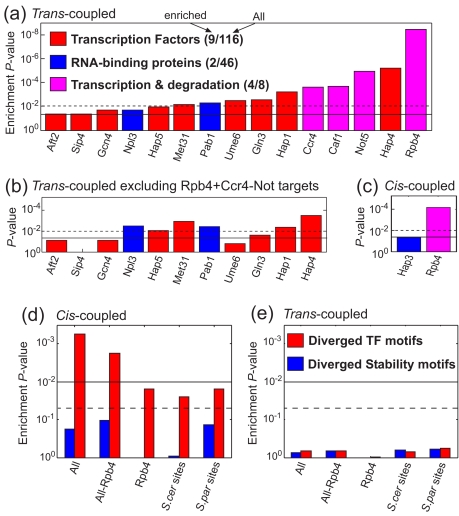
Coupling is associated with divergence of Rpb4/7, Ccr4-Not, and TF motifs.(a) Target-sets of various TFs [31], RNA-binding proteins [14], and two complexes implicated in both transcription and degradation (Rbp4/7 [32] and Ccr4-Not [33]) were examined for enrichment with trans-coupled genes. 15 and 10 datasets had significant enrichment below a p value of 0.05 (full line) and 0.01 (dashed line), respectively, and these are shown in order of statistical significance. The total numbers of analyzed datasets and those with significant enrichments are shown in parentheses. (b) Same as in (a) after excluding targets of Rpb4, Ccr4, and Not5. (c) Same as in (a) for enrichment with cis-coupled genes. (d) Diverged TF binding [31] (red) or mRNA stability [15] (blue) motifs, which are intact only in S. cerevisiae (S. cer sites) or only in S. paradoxus (S. par sites), were identified by sequence analysis. The enrichment of diverged motifs (for all TFs combined or all stability motifs combined) was examined among all cis-coupled genes (All), cis-coupled genes predicted to be targets (Rpb4) or non-targets (All-Rpb4) of Rpb4, and for cis-coupled S. cer sites or cis-coupled S. par sites. (e) Same as (d) for enrichment with trans-coupled genes.